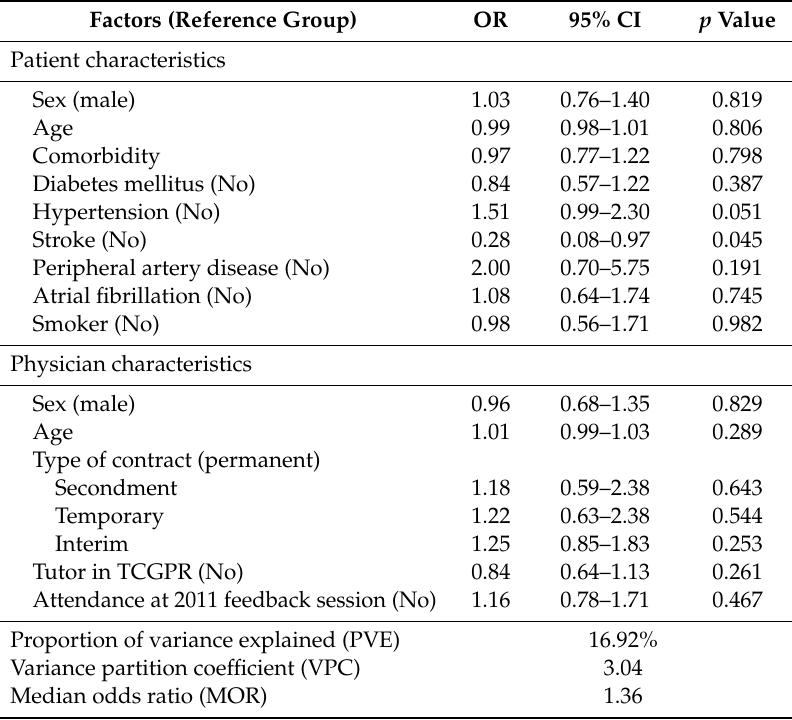
Table 5. Multivariate multilevel analysis showing the association between LDL-C control after Phase 2 of CPG implementation and patient and doctor